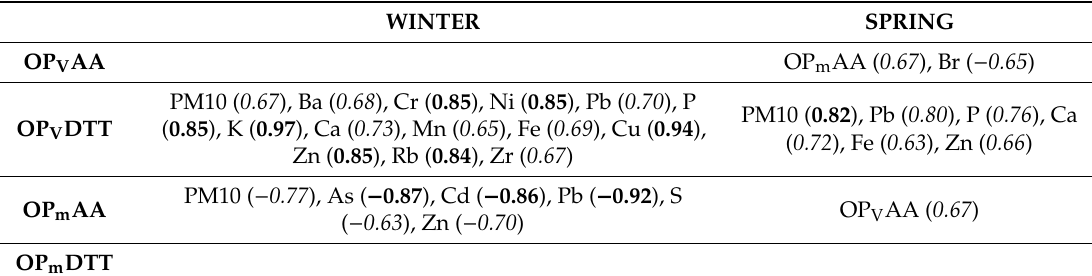
Table 3. AA and DTT volume- and mass-normalized oxidative potential responses (OP V and OP m , respectively) positively and negatively correlated with total (all analyzed chemical elements) and PM10 mass concentration for the 10 winter samples and the 10 spring samples. Spearman correlation coe ffi cients are reported in brackets (values significant at p -levels of < 0.01 and 0.05 are in bold and in italics,